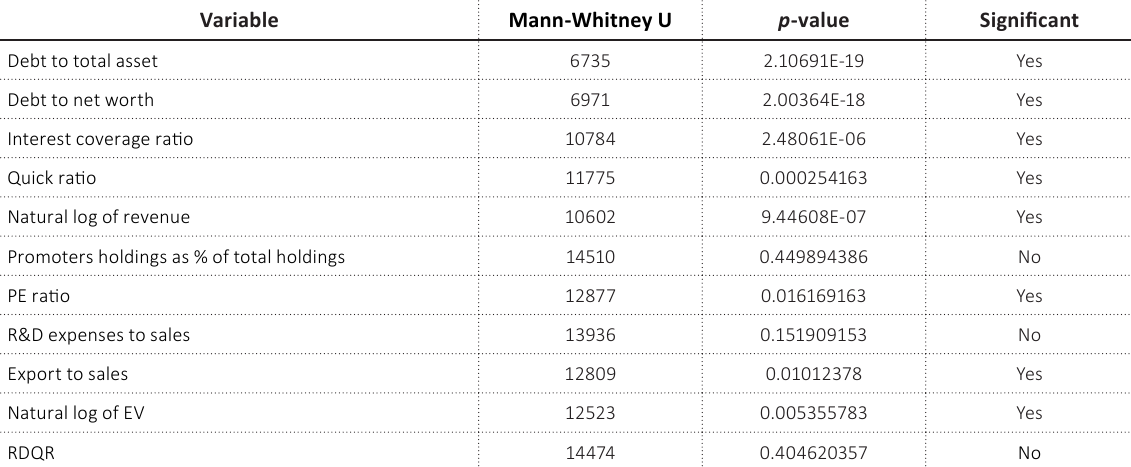
Table 3. Results of univariate analysis (difference between means of users vs. non-users of foreign currency